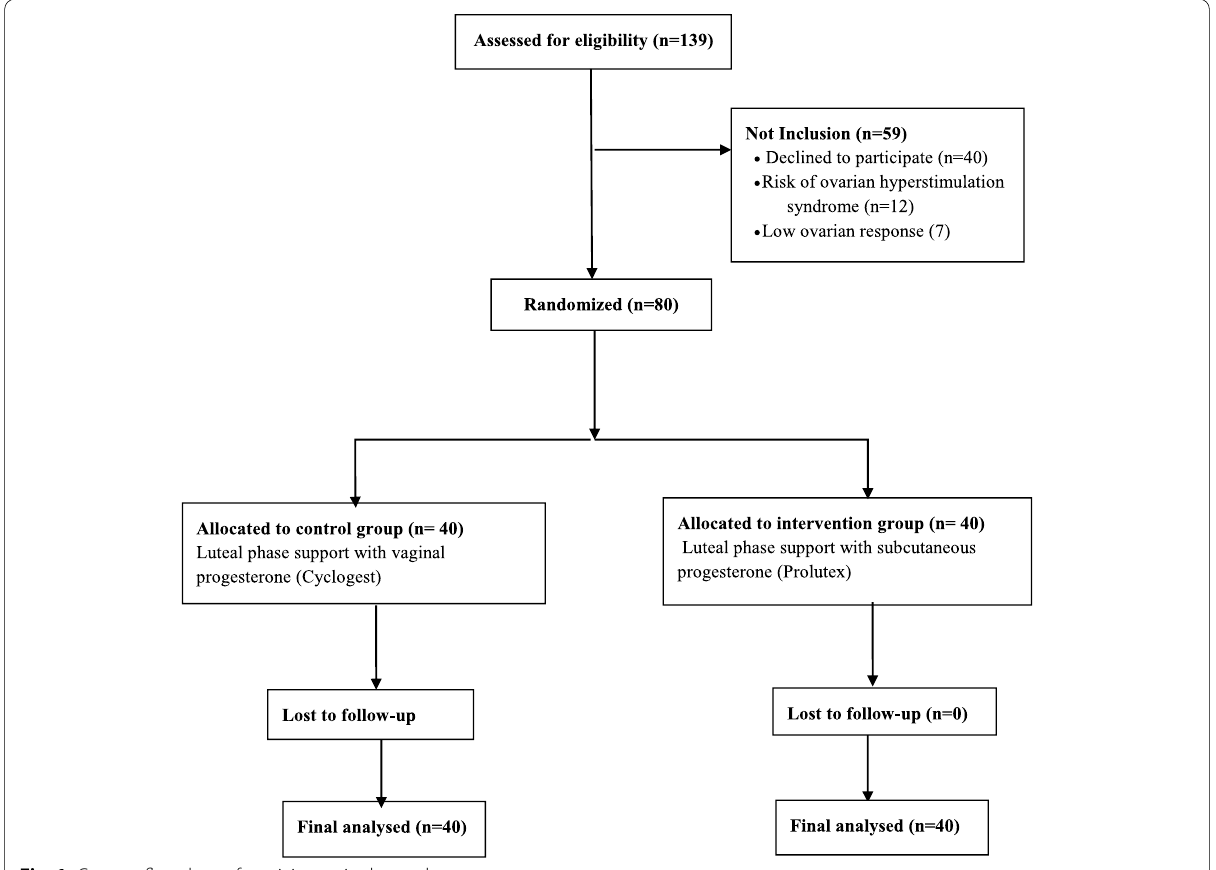
Fig. 1 Consort flowchart of participants in the